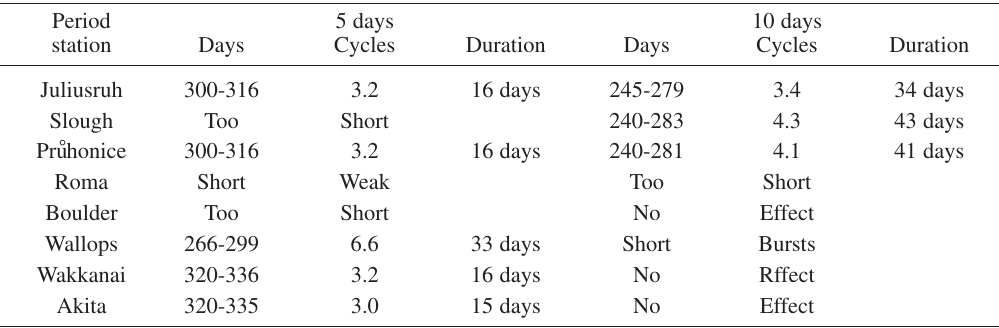
Table VII. A T = 5 days event and a T = 10 days event, both observed in the second half of 1986, Morlet wavelet transform. Too short means shorter than 3.0 cycles; short bursts means only short, separated bursts occur. Period 5 days 10 days station Days Cycles Duration Days Cycles Duration Juliusruh 300-316 3.2 Slough Too Short Pru ° honice Roma Short Weak Too Short Boulder Too Short No Effect Wallops 266-299 Bursts